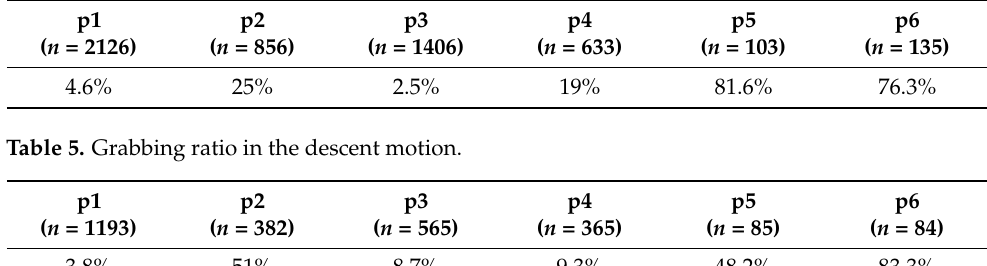
Figure 7. Comparison of the descent speed between participants. Blue circles and error bars indicate the mean values and standard deviations. respectively.